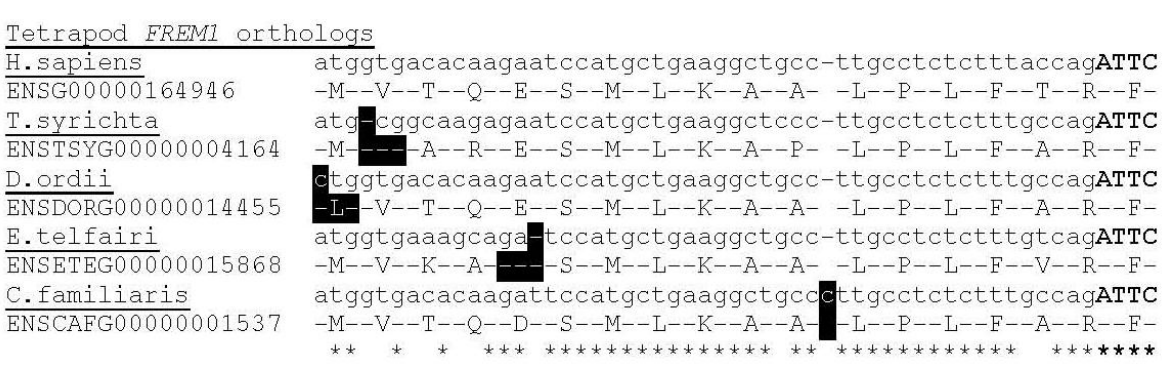
Figure 3. Identification of single base mutations responsible for non-homologous sequence in C. familiaris , D. ordii , T. syrichta and E. telfairi .